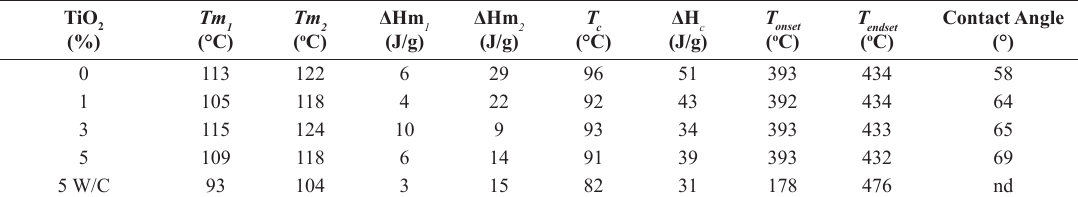
nanocomposites with 1, 3, 5% TiO 2